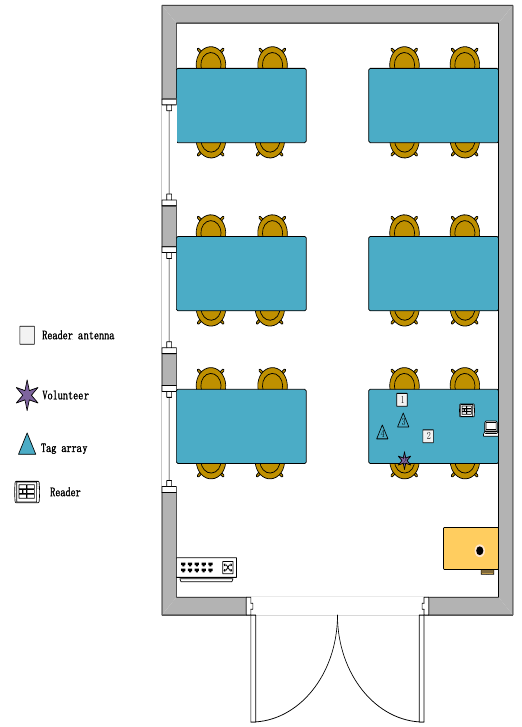
Figure 12. Classroom experiment scene diagram.